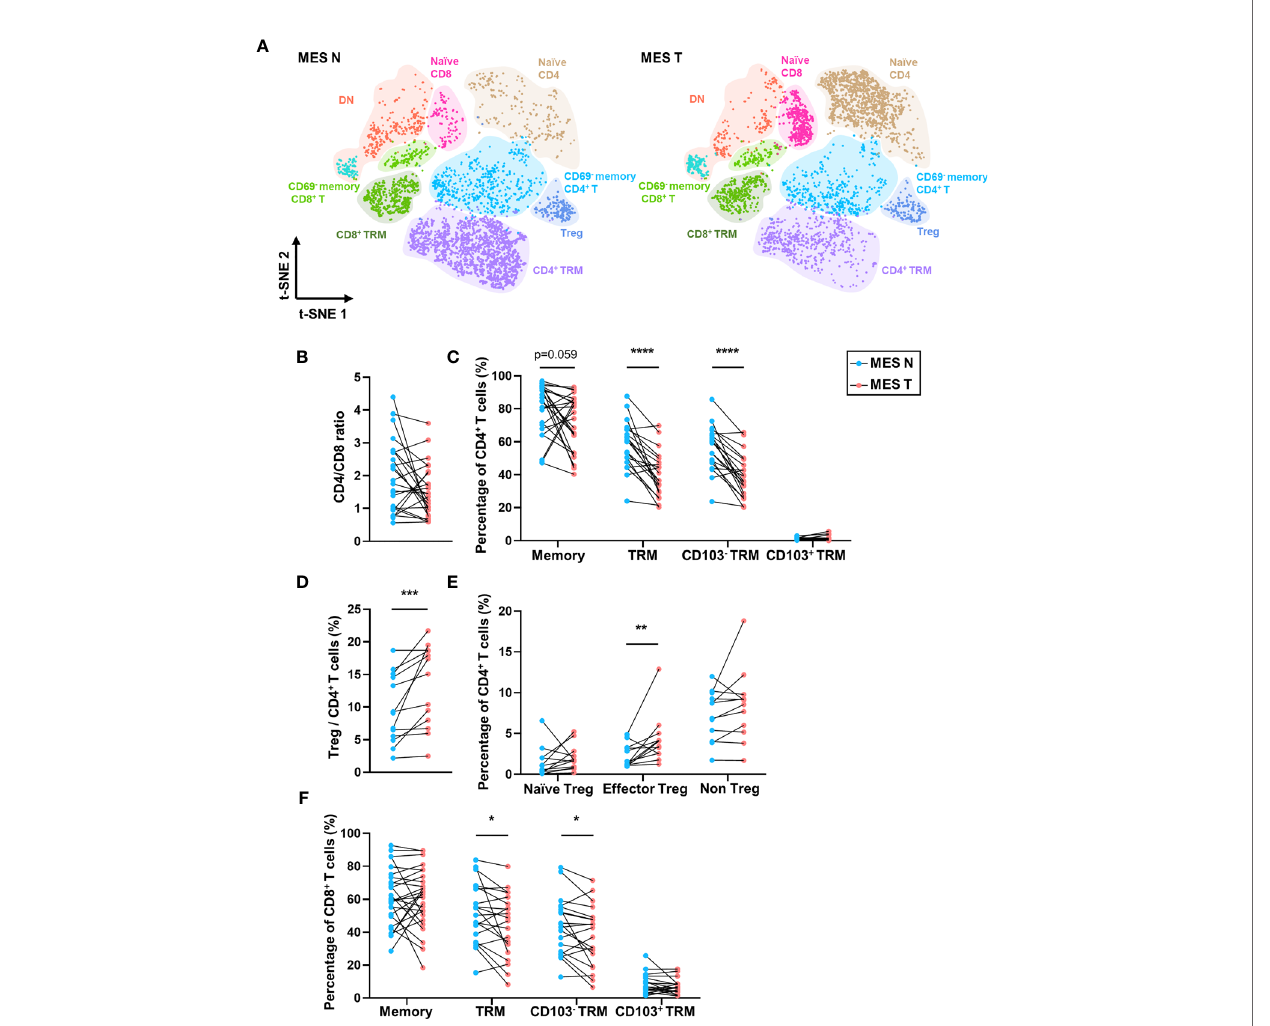
FIGURE 4 | T-SNE plot and percentages of T cells in the MES N and MES T. (A) T-SNE plot of T cells in the MES N and MES T with main subclusters indicated. (B) CD4/CD8 ratio in the MES N and MES T. (C) Percentages of memory CD4 + T cells, CD4 + TRM cells, CD4 + CD103 - TRM cells, and CD4 + CD103 + TRM cells in the MES N and MES T. (D) Percentage of Treg cells in the MES N and MES T. (E) Percentages of naïve Treg cells, effector Treg cells, and non Treg cells in the MES N and MES T. (F) Percentages of memory CD8 + T cells, CD8 + TRM cells, CD8 + CD103 - TRM cells, and CD8 + CD103 + TRM cells in the MES N and MES T. (*p < 0.05; **p < 0.01; ***p < 0.001; ****p <